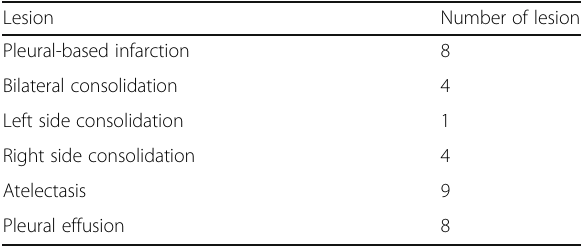
Table 3 The characteristics of the pulmonary